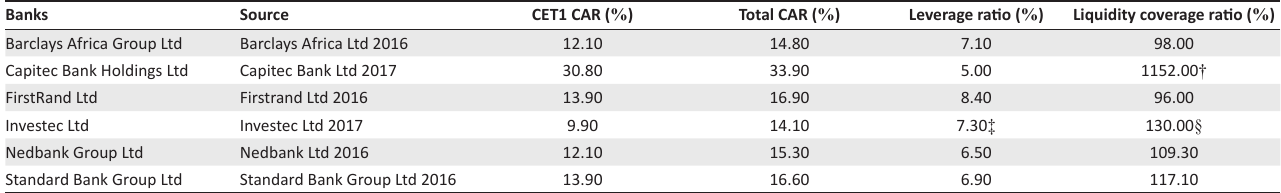
TABLE 1: Selected regulatory indicators according to Basel III for the top six South African banks for year-end 2016. Banks Source CET1 CAR ( % ) Total CAR ( % ) Leverage ratio ( % ) Liquidity coverage ratio ( %